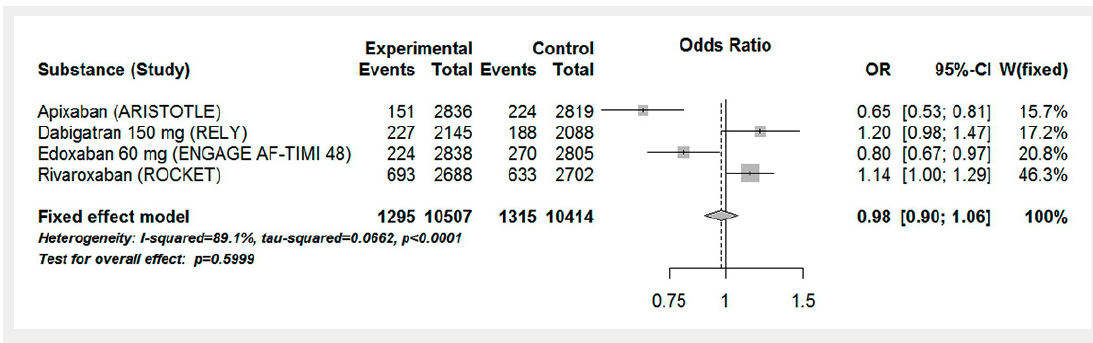
Figure 5 Forest plot of composite major and clinically relevant non-major bleeding in patients with atrial fibrillation aged 75 years or over for analysis including high-dose dabigatran and edoxaban. CI = confidence interval; experimental = direct oral anticoagulants; control = vitamin K